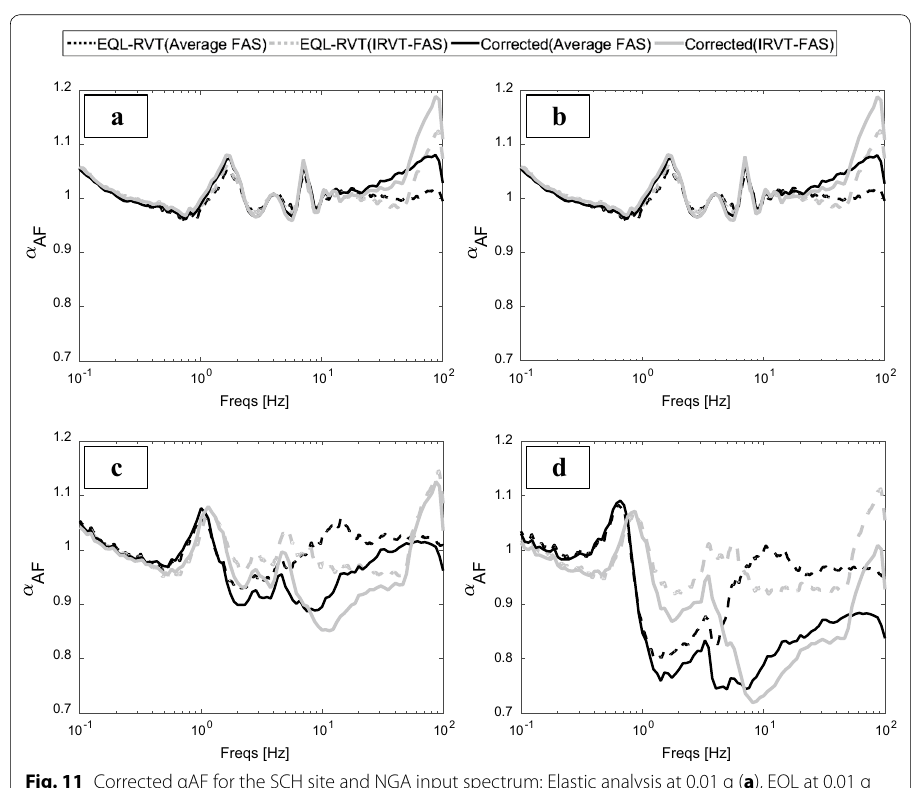
Fig. 11 Corrected αAF for the SCH site and NGA input spectrum: Elastic analysis at 0.01 g ( a ), EQL at 0.01 g ( b ), EQL at 0.3 g ( c ) and EQL at 0.6 g ( d